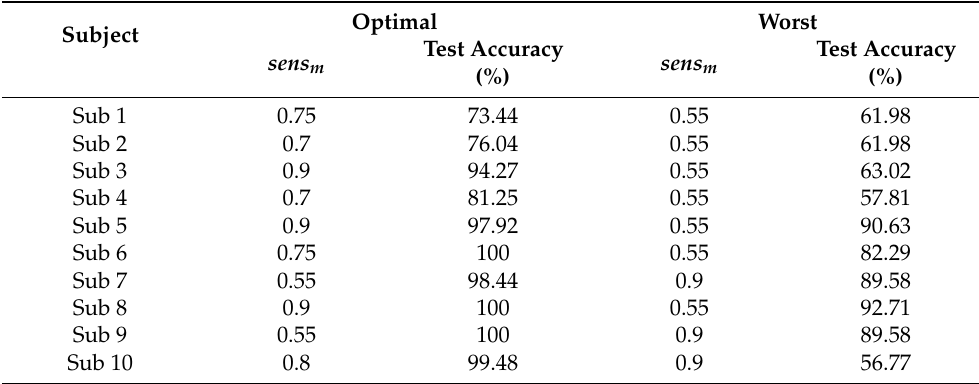
Table 2. Classification results with optimal and worst sens